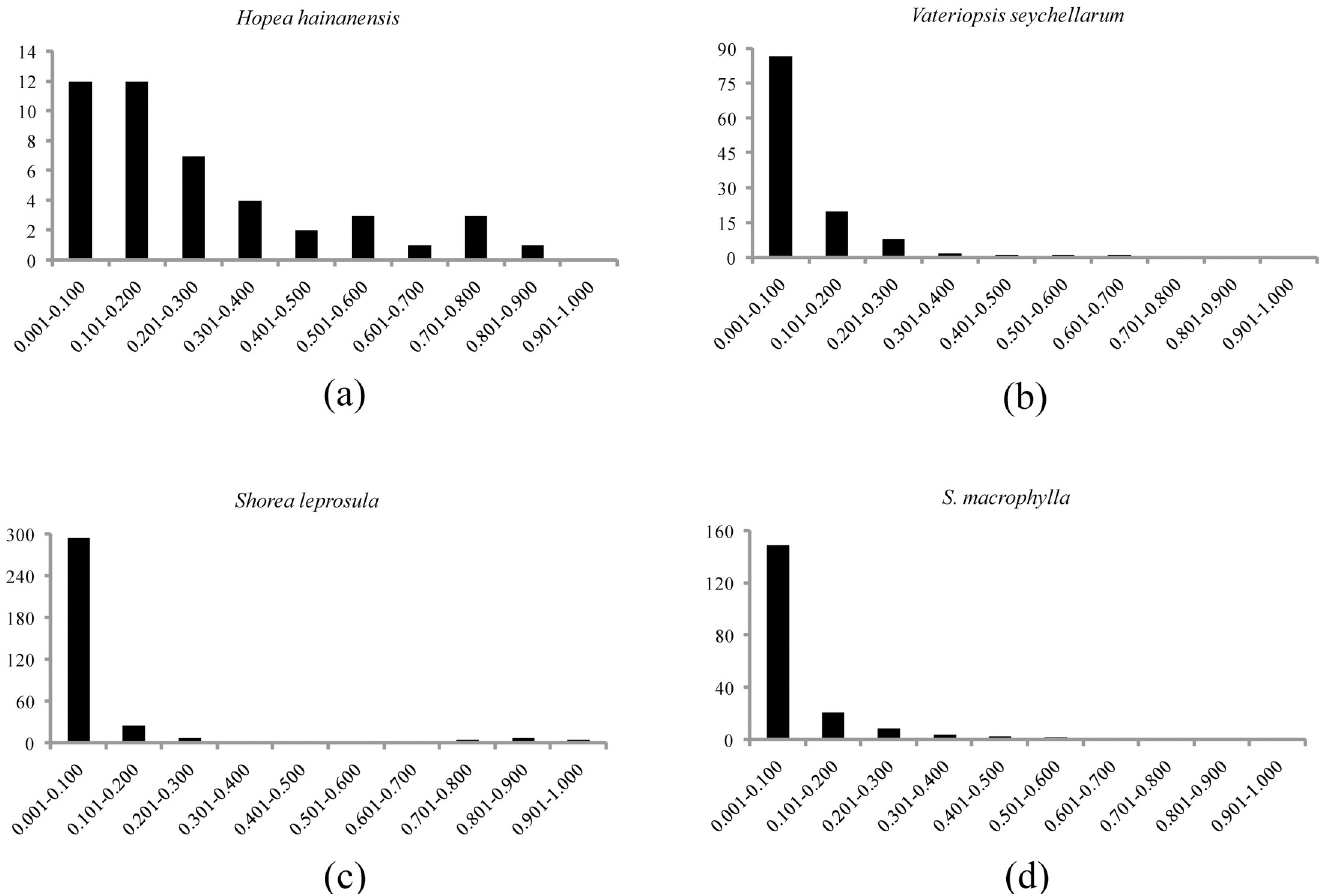
Fig 4. The allele frequency distributions based on SSR data from Hopea hainanensis , Vateriopsis seychellarum , Shorea leprosula and S . macrophylla .